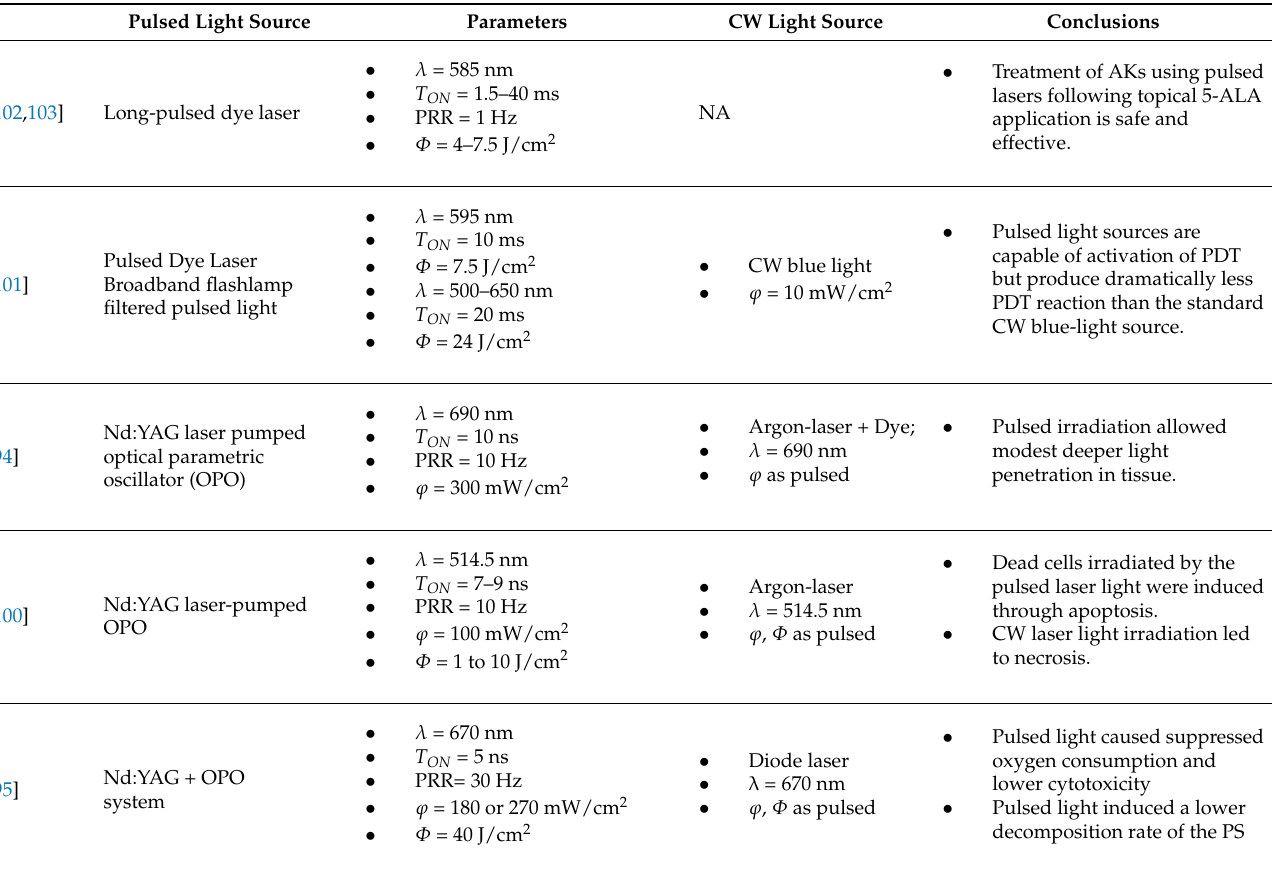
Table 2. Characteristics and conclusions derived from empirical studies using pulsed light sources in superficial and I-PDT. T ON stands for the pulse duration of the laser, PRR for the pulse repetition rate or frequency, ϕ for the average fluence rate and Φ for the average fluence. Adapted and updated from [97]. Pulsed Light Source Parameters CW Light Source